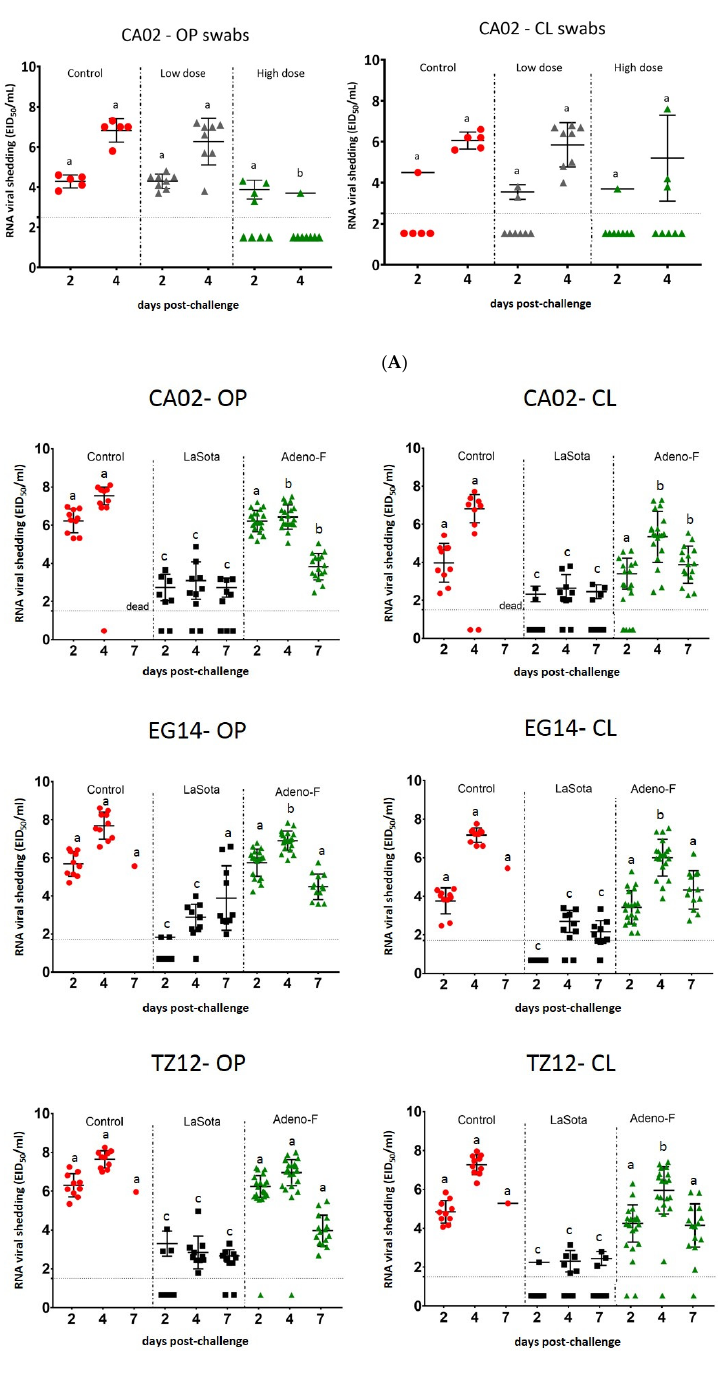
Figure 3. Vaccinated and non-vaccinated birds shed virus after NDV challenge in the different experiments. ( A ) Oropharyngeal (OP) and cloacal (CL) swabs from birds in the control group and in groups vaccinated with adeno-F at high and low doses were tested by RRT-PCR after 2 and 4 days post-challenge (dpc). ( B ) Virus shedding from vaccinated birds with LaSota and adeno-F vaccines and non-vaccinated birds in OP and cloacal swabs at 2, 4, and 7 days after challenge with CA02, EG14, or TZ12. Viral titers in OP or CL swab samples from the different treatments (control, adeno-F—low and high doses, and LaSota) on the same day and with the same NDV challenge strain. The mean ± standard errors with different letters (a, b, or c) are statistically significant ( p < 0.05). CL: cloacal swab; OP: oropharyngeal swab.